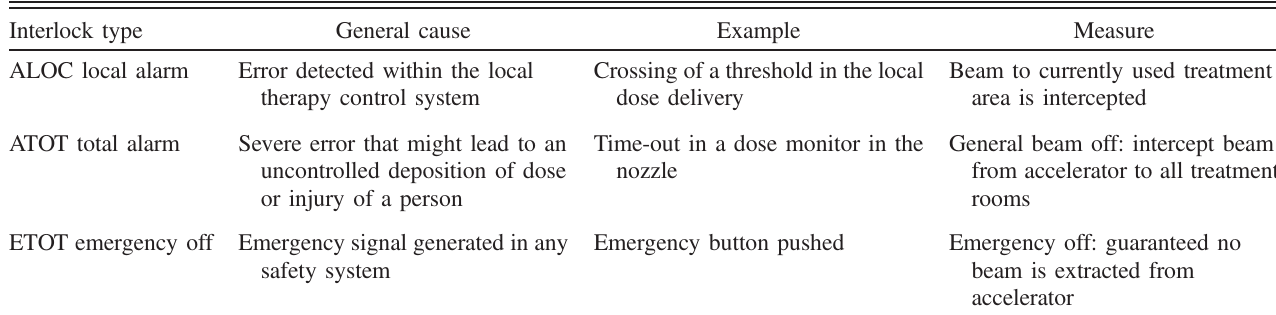
TABLE 1. Patient-safety-related interlock signals of the system at PSI and examples of their causes, illustrating the different beam- switch-off